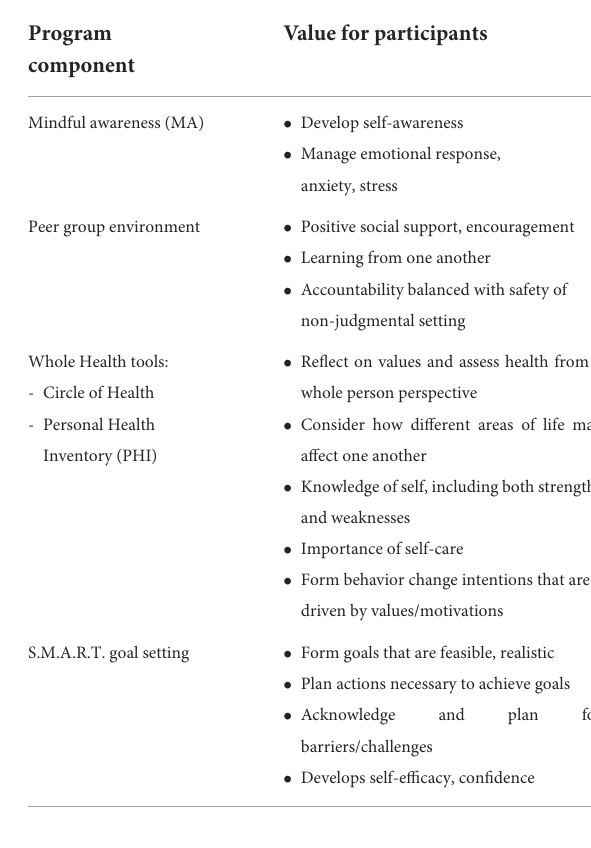
TABLE 1 Overview of interview participant characteristics ( n = 19). TABLE 2 Themes—important/impactful program components of